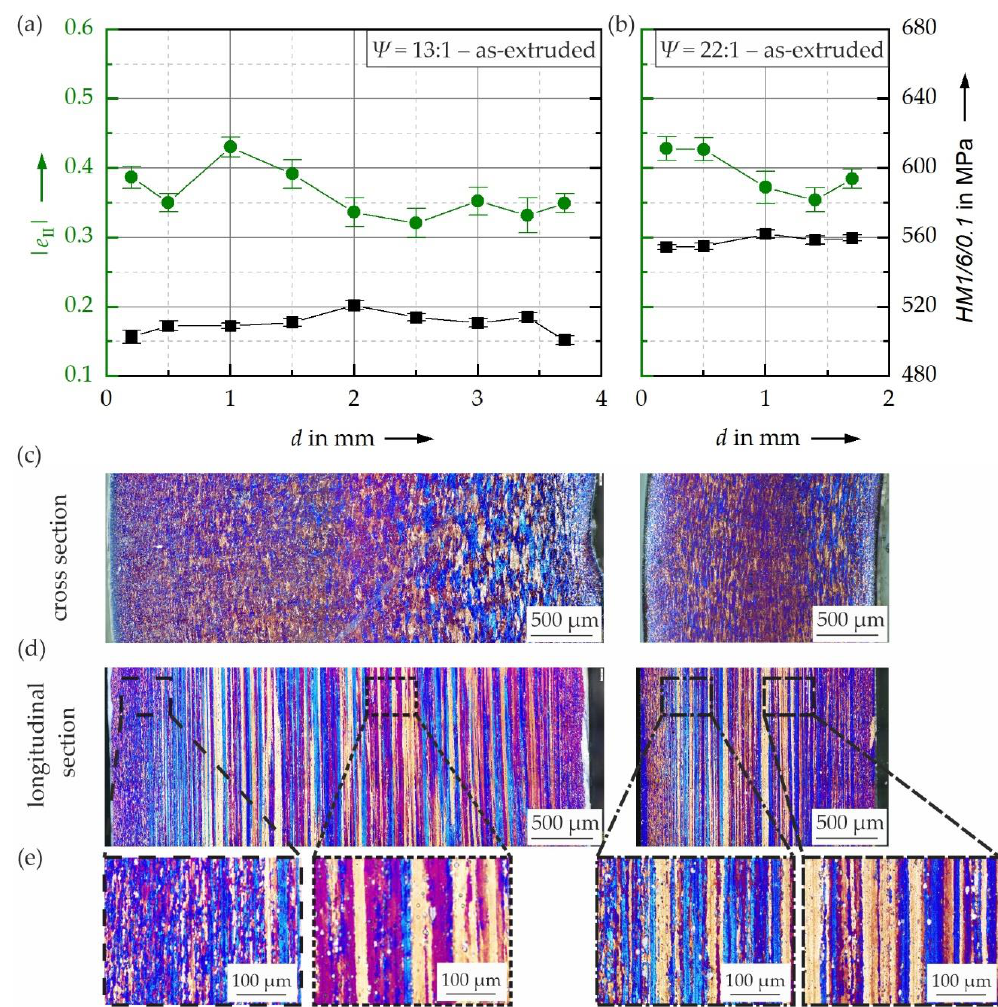
Figure 5. Martens hardness HM1/6/0.1 and cyclic hardening exponent CHT | e II | of as-extruded state with ( a ) Ψ = 13:1 and ( b ) Ψ = 22:1, depending on the distance d from the outer surface; light optical micrographs of ( c ) cross sections and ( d ) longitudinal sections as well as ( e ) close-up views.